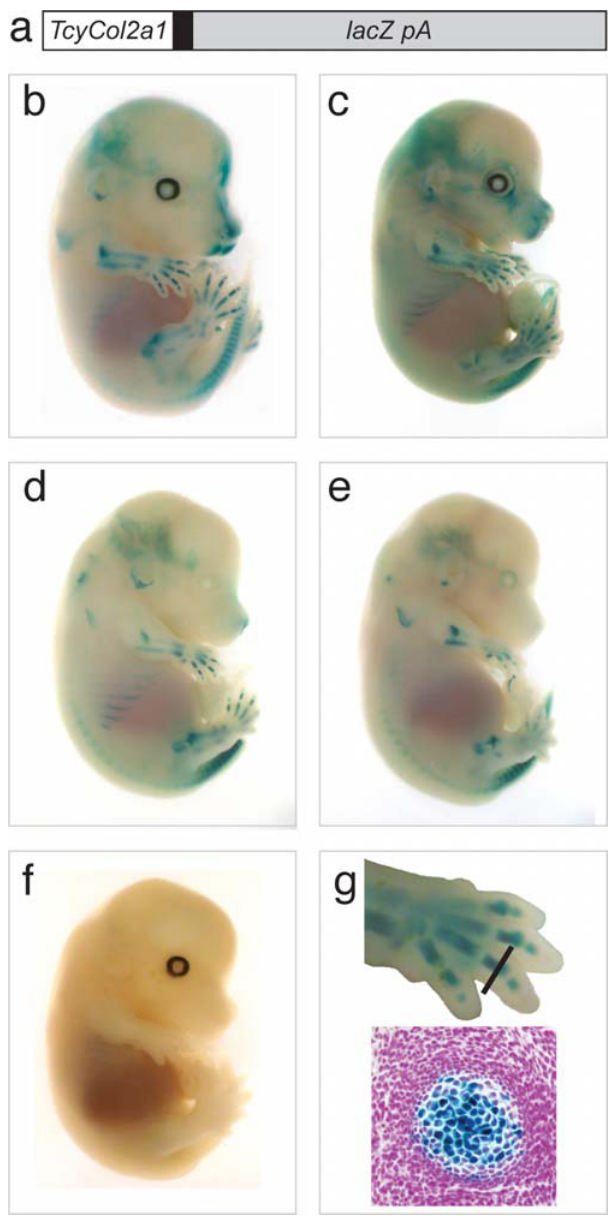
Figure 3. From extinction to gene expression. Functional analysis of the thylacine non-coding DNA fragment. ( a ) Diagram of transgene construct. 4 copies of a 264-bp fragment containing the Thylacine Col2a1 enhancer ( TcyCol2a1 ) region was ligated to the human b-globin minimal promoter (black box) and ligated to lacZpA . ( b–e ) X-gal stained 14.5 dpc TcyCol2a1-lacZpA transgenic mouse embryo showing varying levels of reporter gene expression within the developing cartilage (blue). ( f ) Non-transgenic littermate, negative control fetus. ( g ) Top panel; Magnified image of forelimb from fetus in (b) black line indicates the plane of section shown in (g) bottom panel. Bottom panel; Histological section of transgenic forelimb digit, showing lacZ - expressing chondrogenic tissue (blue) counterstained with eosin